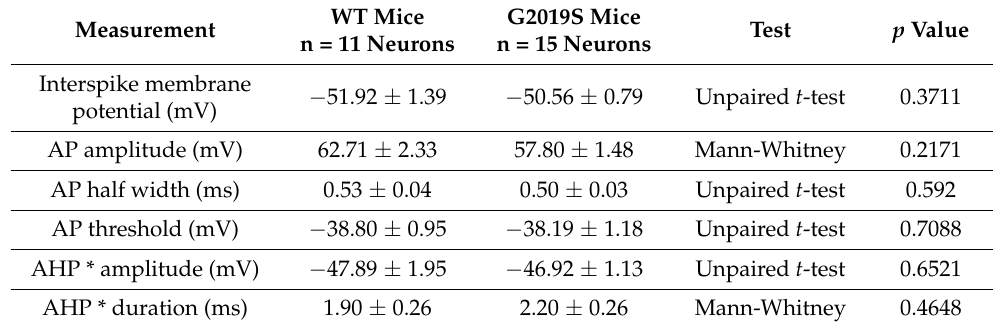
Table 1. Action potential (AP) properties of SNr neurons in WT and G2019S